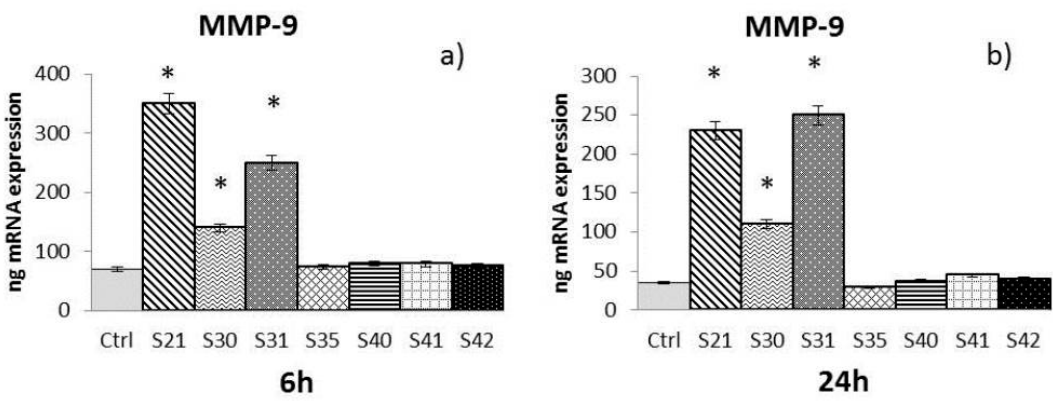
Figure 4. mRNA expression of Metalloproteinase-9 (MMP-9) from HaCat cells treated with S21, S30, S31, S35, S40, S41 and S42 non-woven tissue bio-composites (10 μ g/mL) for 6 h ( a ) and 24 h (b). Data are mean ± SD of values calculated on two different experiments. *P < 0.05 compared to Ctrl.